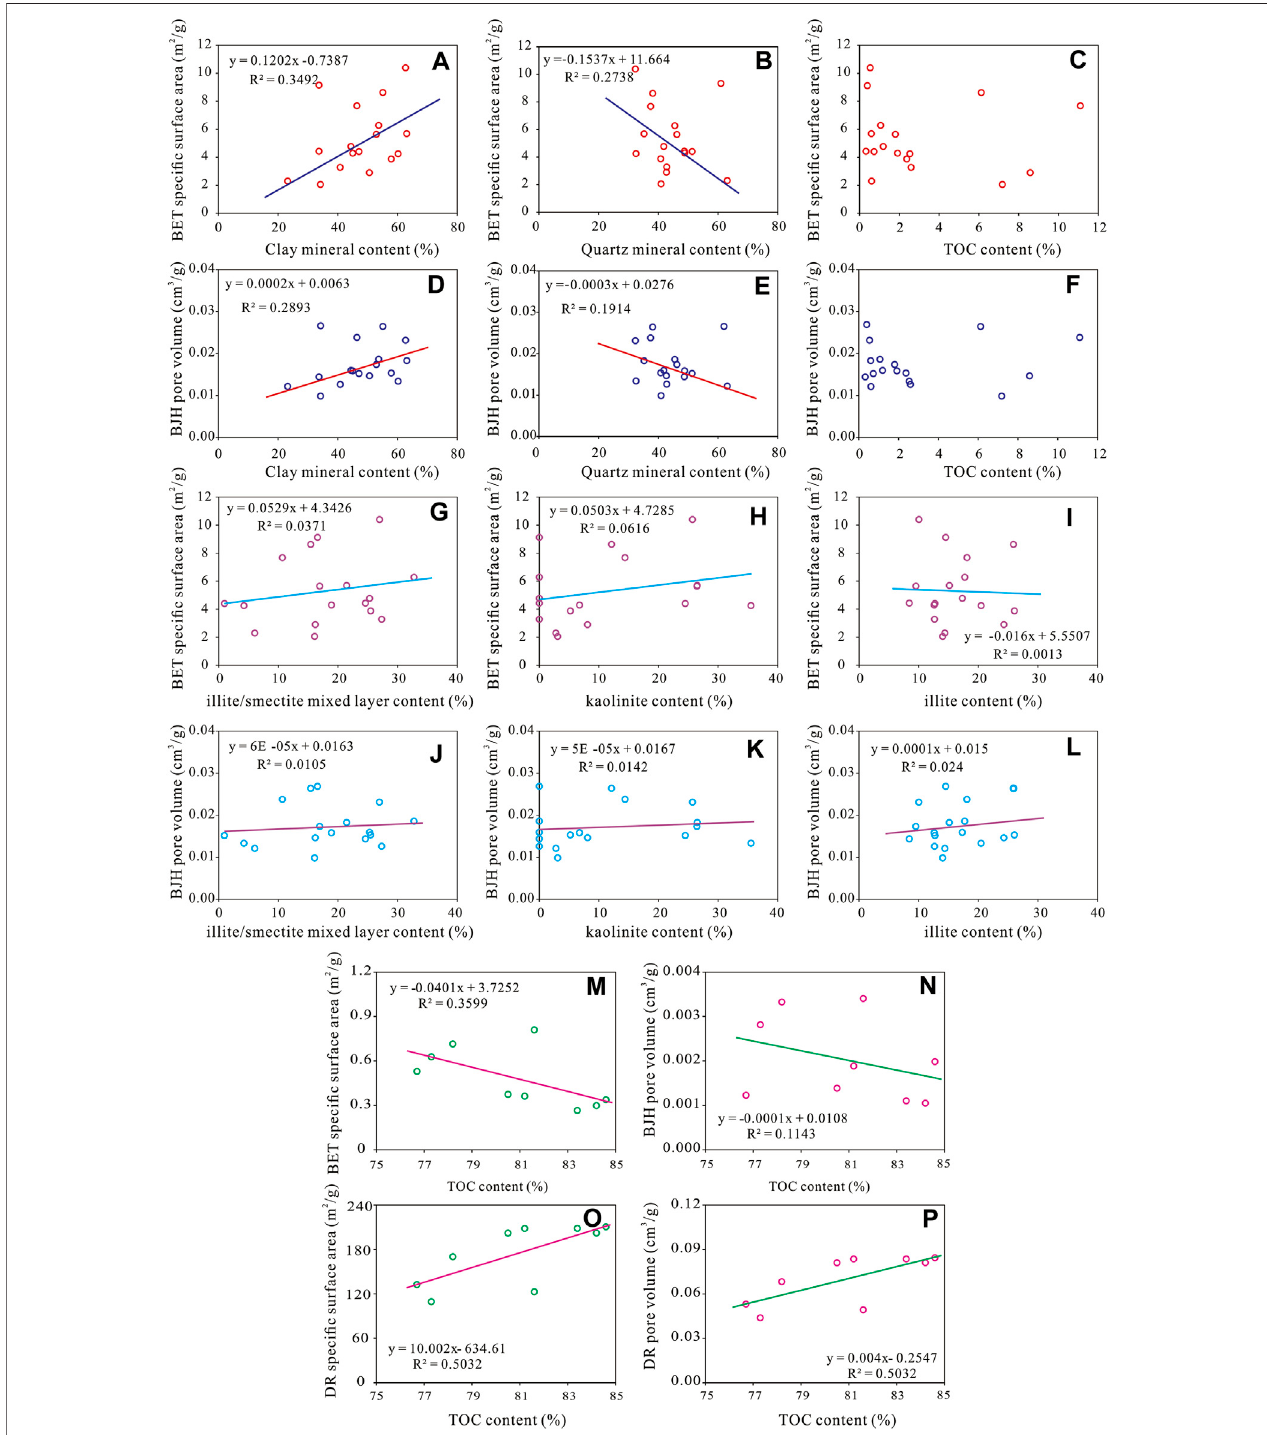
FIGURE11| Correlationanalysisoffactorsin fl uencingporedevelopment. (A – C) Correlationbetweenclay,quartz,organiccarbonandBETspeci fi csurfaceareain shale and tight sandstone. (D – F) Correlation between clay, quartz, organic carbon and BJH pore volume in shale and tight sandstone. (G – I) Correlation between illite/ smectite mixed layer, kaolinite, illite and BET speci fi c surface area in shale and tight sandstone. (J – L) Correlation between illite/smectite mixed layer, kaolinite, illite and BJH pore volume in shale and tight sandstone. (M) Correlation between TOC and BET speci fi c surface area in coal. (N) Correlation between TOC and BJH pore volume in coal. (O) Correlation between TOC and DR speci fi c surface area in coal. (P) Correlation between TOC and DR pore volume in coal.